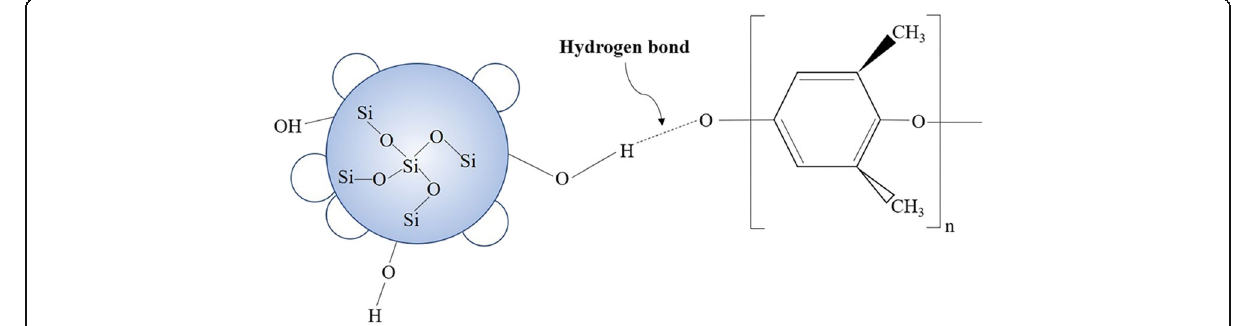
Fig. 1 Schematic hydrogen bonding (dotted line) between silica and polyphenylene oxide matrix